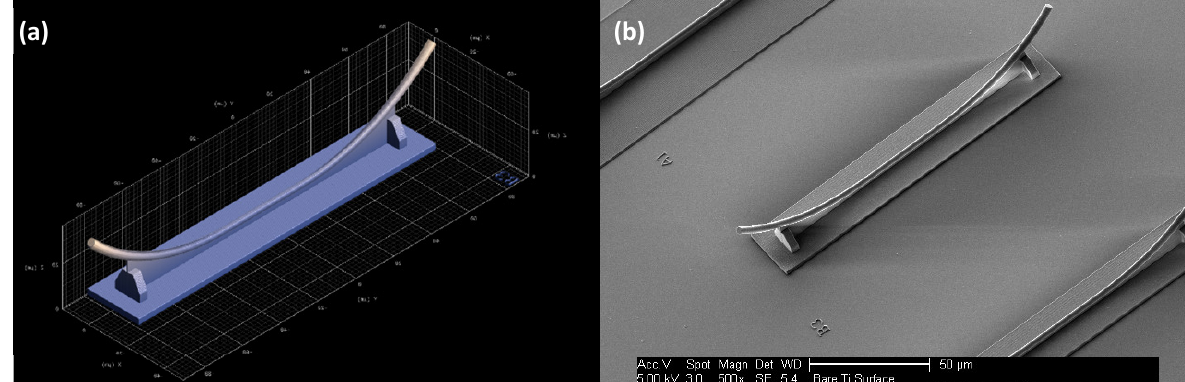
Figure 7. ( a ) Isometric view of 3D waveguide design in software. ( b ) HRSEM image of fabricated waveguide supported by the nano-fin.